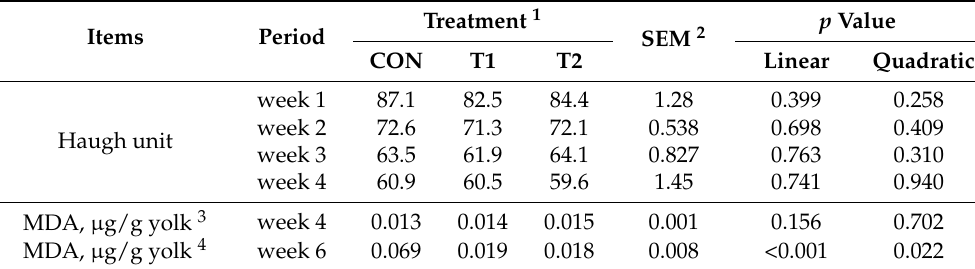
Table 7. Changes in Haugh unit and lipid oxidation of eggs during